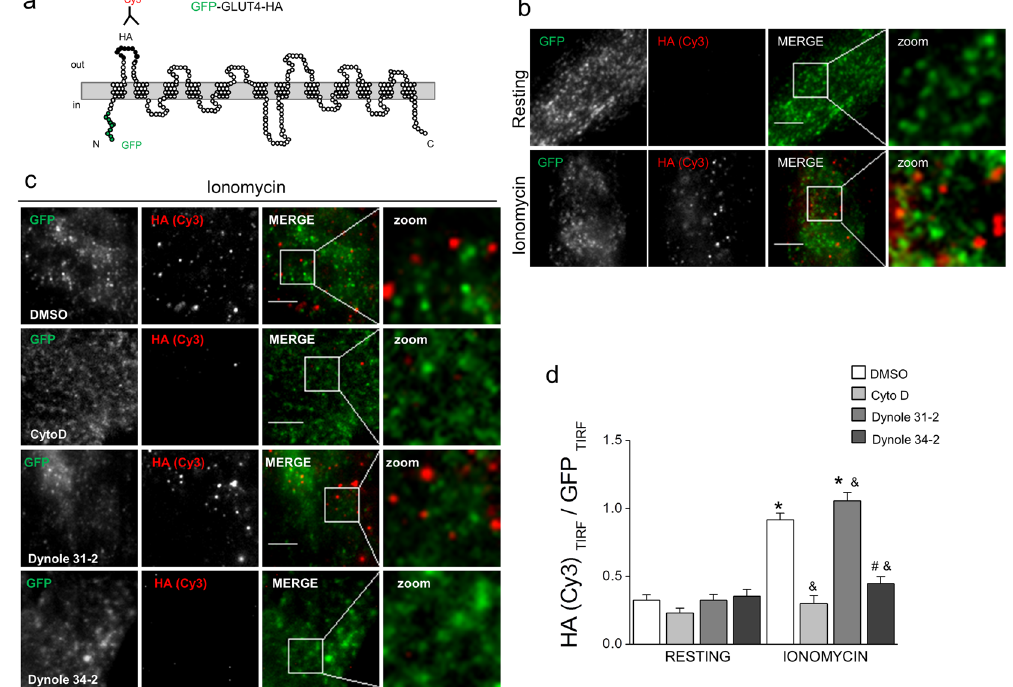
Figure 2. Pharmacological inhibition of dynamin GTP-activity reduces GLUT4 insertion in the plasma membrane of RCMH myoblasts. Cultured RCMH myoblasts were transfected with the GFP-GLUT4-HA construct and 48 ± 2 h later were stimulated for 5 min with 20 µ M ionomycin in the presence of 20 µ M dynole 31-2, 20 µ M dynole 34-2, 4 µ M CytoD or the vehicle DMSO at 37 °C, fixed, immunolabeled with an anti-HA antibody without permeabilization, incubated with a Cy3-conjugated antibody and visualized by TIRF microscopy. The plasma membrane insertion of GLUT4 was quantified as a ratio between Cy3 (red) and GFP (green) signals in the evanescent field. ( a ) Schematic representation of the GFP-GLUT4-HA construct; GFP is located in the N-terminal intracellular loop and the exofacial hemaglutinin (HA)-tag in the first extracellular loop. ( b ) Examples of TIRF images of non-treated cells under resting (upper panels) or stimulated (bottom panels) conditions (250 × 250 pixels images are shown). Note that ionomycin induces GLUT4 translocation, as the HA (Cy3) signal in the evanescent field becomes detectable (red spots). ( d ) 250 × 250 pixels representative images of RCMH cells stimulated in the presence of DMSO, CytoD, dynole 31-2 or dynole 34-2. Cell periphery is drawn in white. ( e ) HA (Cy3)/GFP ratio in the evanescent field is plotted for each experimental condition. Note that, as CytoD does, dynole 34-2 significantly inhibits the stimulus-dependent plasma membrane insertion of GLUT4. Data are means ± SEM. Statistical comparisons were performed utilizing a two-tail t-test Welch corrected for parametric data. The symbol * denote significance compared to the respective resting condition; & and # symbols denote significance compared to ionomycin-stimulated cells treated with DMSO and Dynole 31-2, respectively. N is between 20 and 29 cells, from at least three different cultures per experimental condition. Scale bar = 10 µ